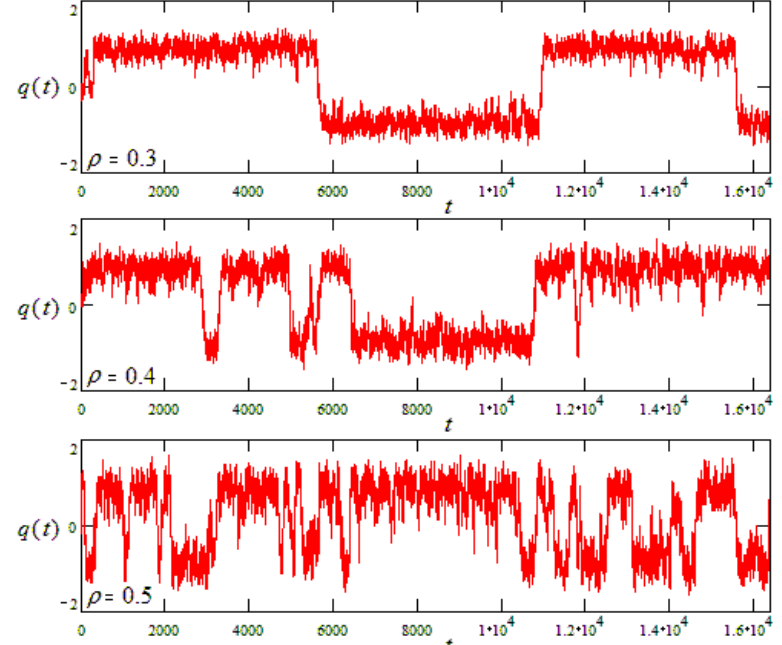
Figure 7: Temporal evolution of the order parameter q ( t ) for the noisy mean-field model in the multimer